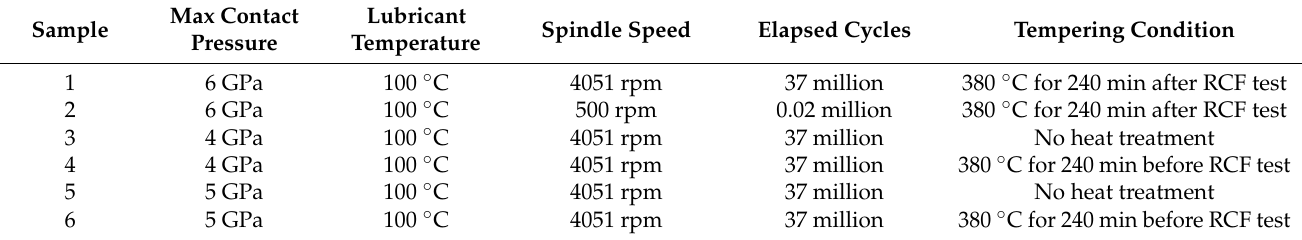
Table 1. Experimentation conducted for tempering analysis.